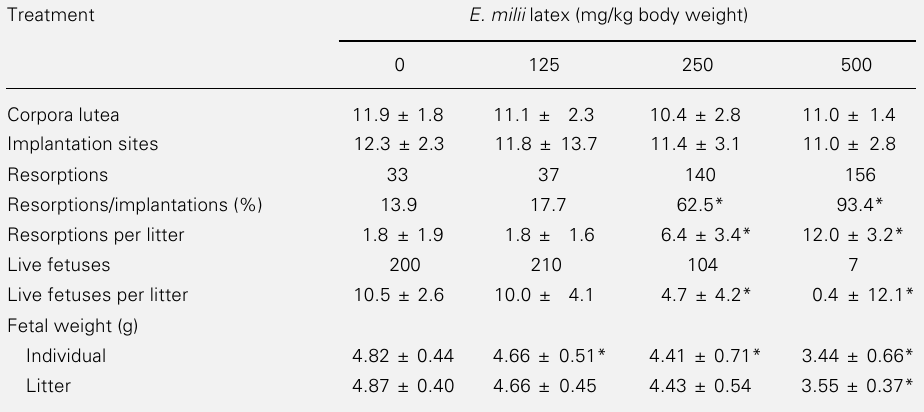
Table 2 - Effects of treatment with E. milii latex (0, 125, 250 and 500 mg/kg, po ) on days 6 to 15 of pregnancy on parameters assessed at the time of cesarean section of rats. Percent resorptions was analyzed by the chi-square test. Numbers of corpora lutea, implantation sites and live fetuses per litter were analyzed by the Kruskal-Wallis test followed by the Mann-Whitney U-test. All other parameters were analyzed by one-way analysis of variance and the Student t -test. Data are reported as mean ± SD. *P<0.05 compared to control.